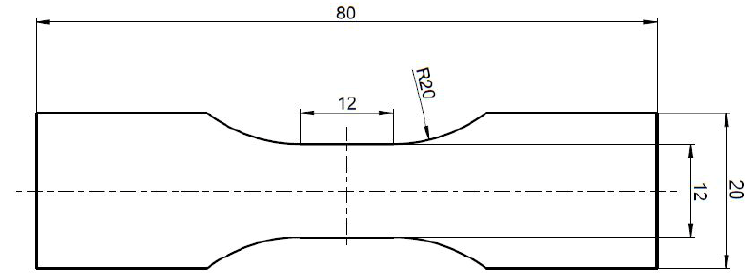
Figure 4. Becker tension rod as used in experiments.